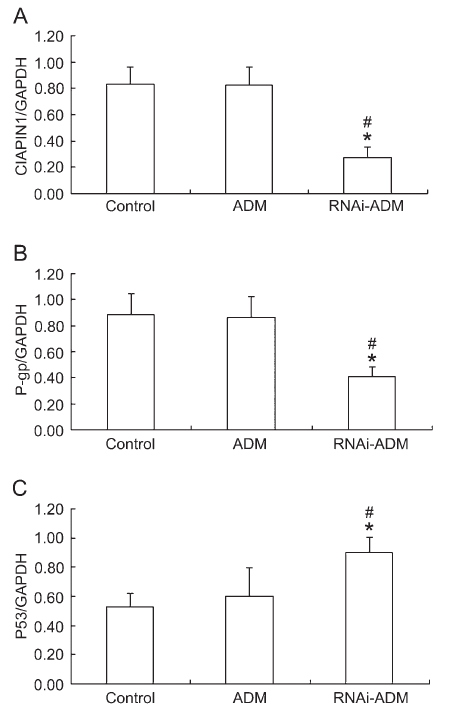
Figure 3. Expression of CIAPIN1 protein (A), P-gp protein (B), and P53 protein (C) in inoculated tumor. *P , 0.05 compared with blank control; # P , 0.05 compared with doxorubicin chemother- apy group (ADM) ( t